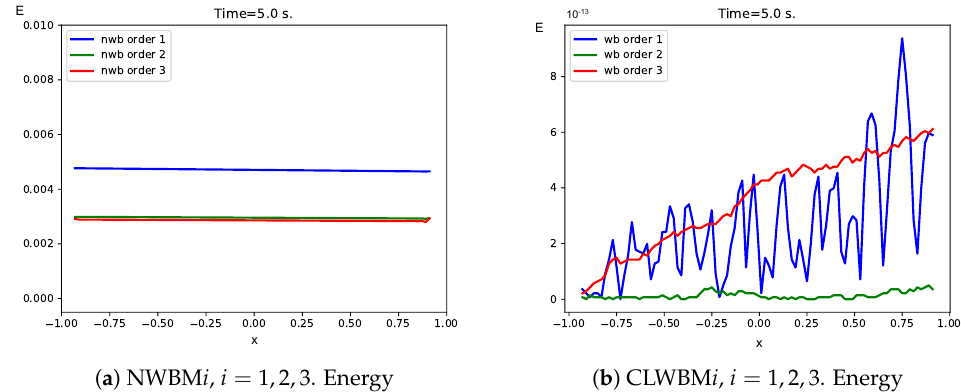
Figure 16. Test 5.1. Differences between the stationary and the numerical solutions at time t = 5 s for E with a mesh of 100